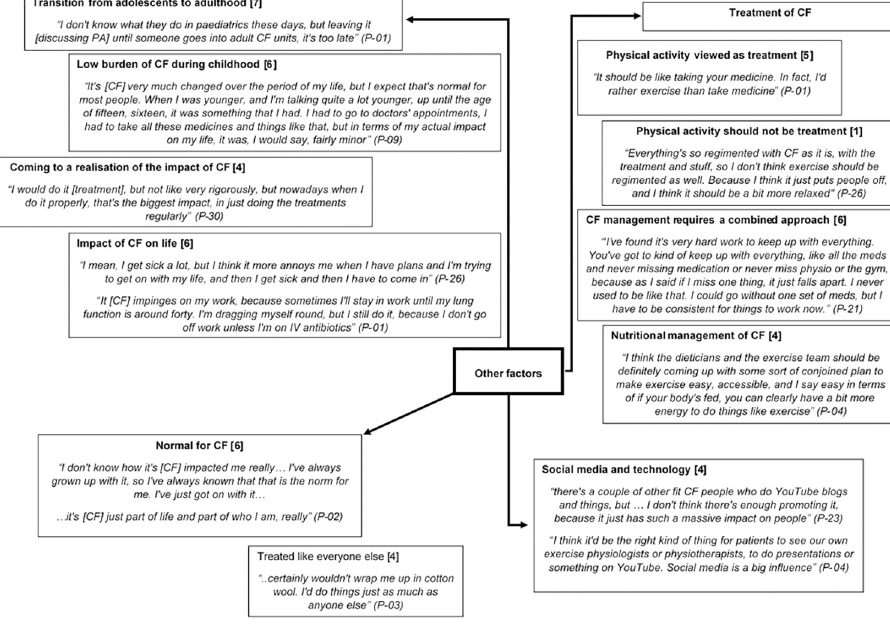
Fig 6. Pen profile displaying ‘other’ factors (n = 11) with illustrative quotes, associated participant number and frequency count provided in square brackets.